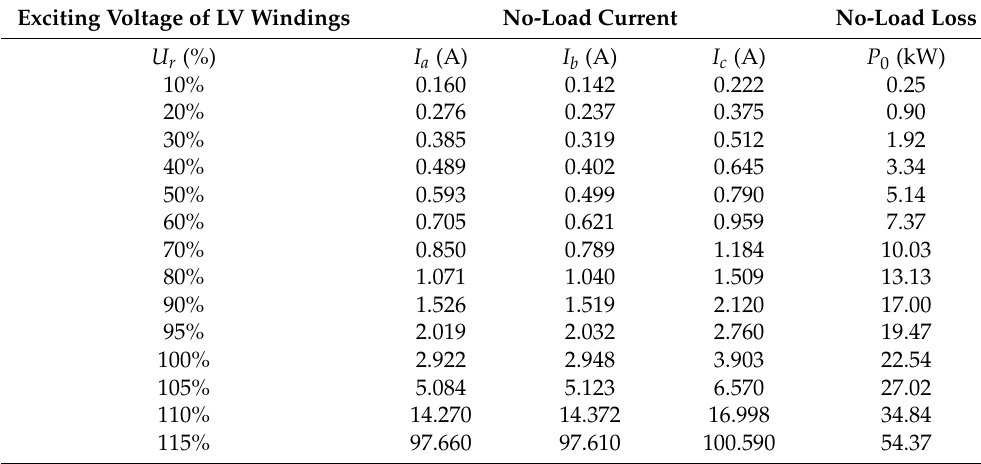
Table 4. Experiment results of no-load test (HV and MV open-circuit, LV